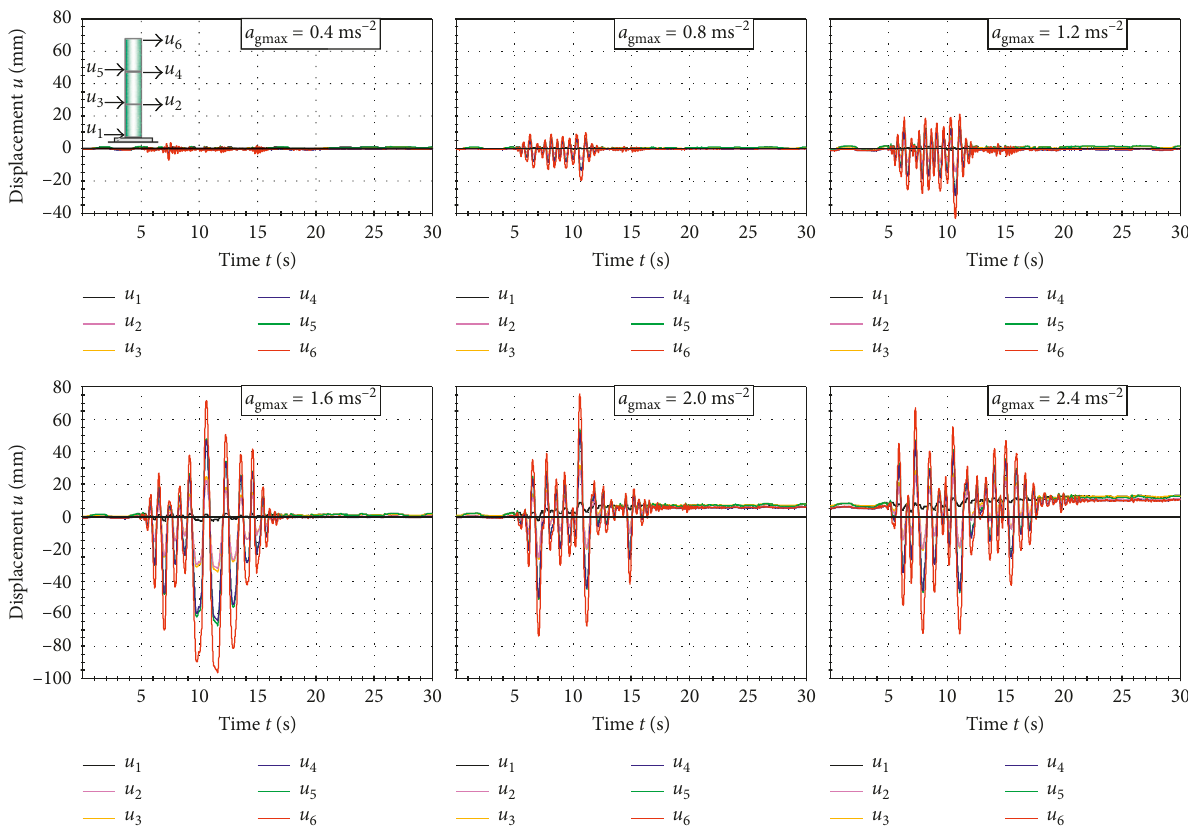
Figure 9: Horizontal displacements u 1 to u 6 of the column S3 for the Petrovac accelerogram at some a gmax .